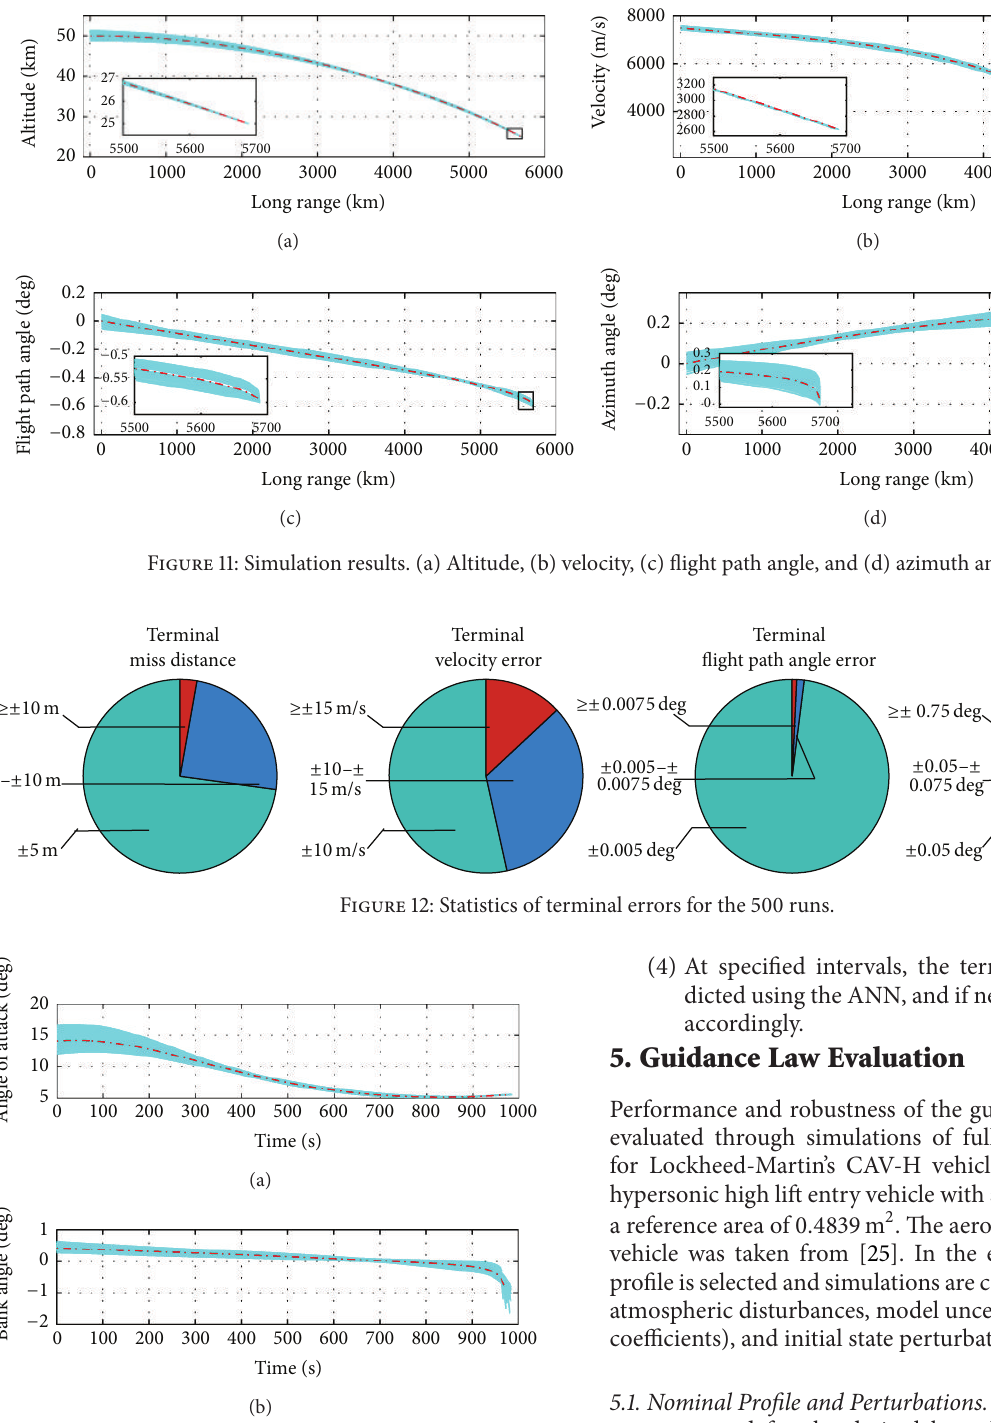
Figure 13: Control history from the simulations. (a) Angle of attack profile and (b) bank angle